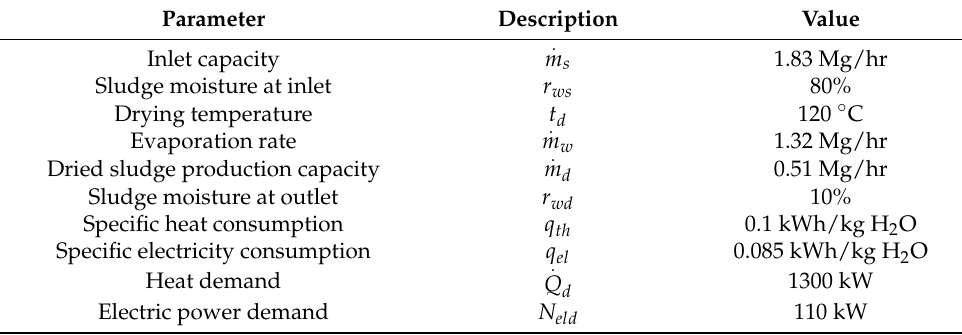
Table 2. Main design parameter and performance data of a case study belt